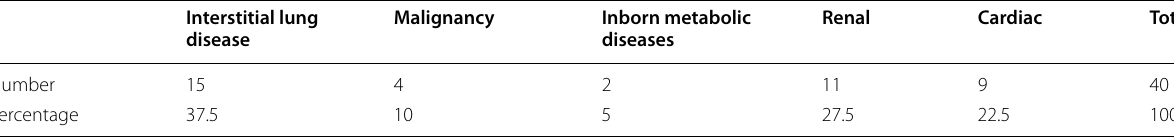
Table 2 Number and diagnosis of excluded cases despite having ALI/ARDS